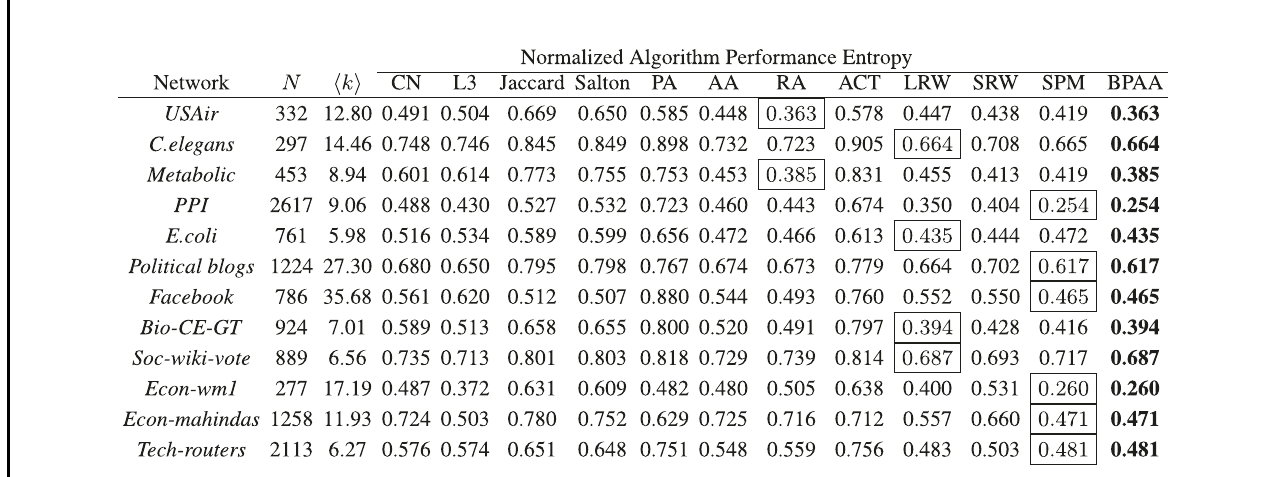
Table 1 Normalized algorithm performance